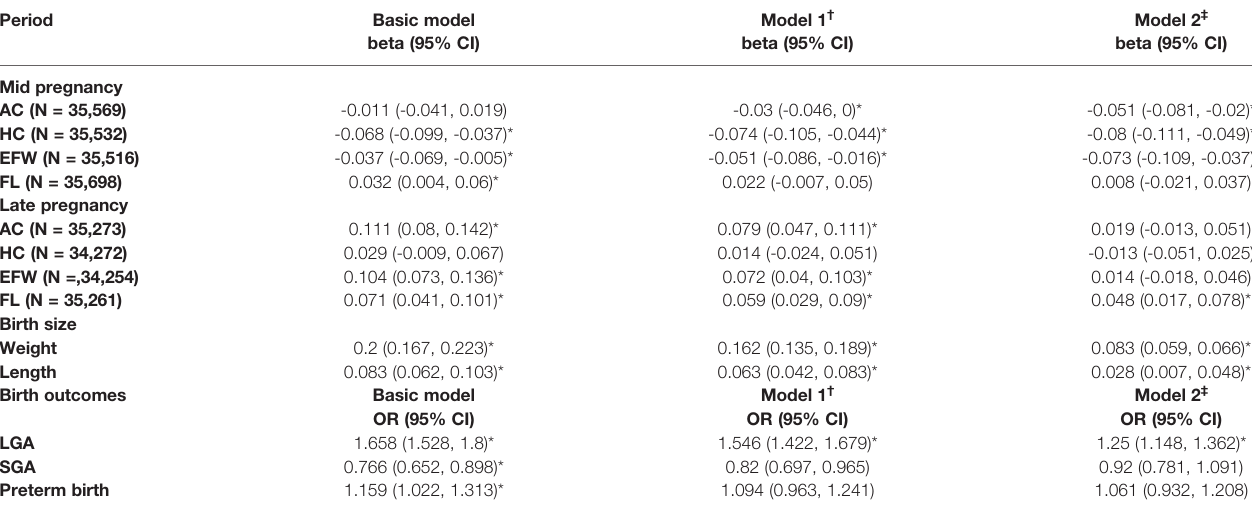
TABLE 2 | Association of maternal early-pregnancy glucose concentrations with fetal growth during pregnancy and birth